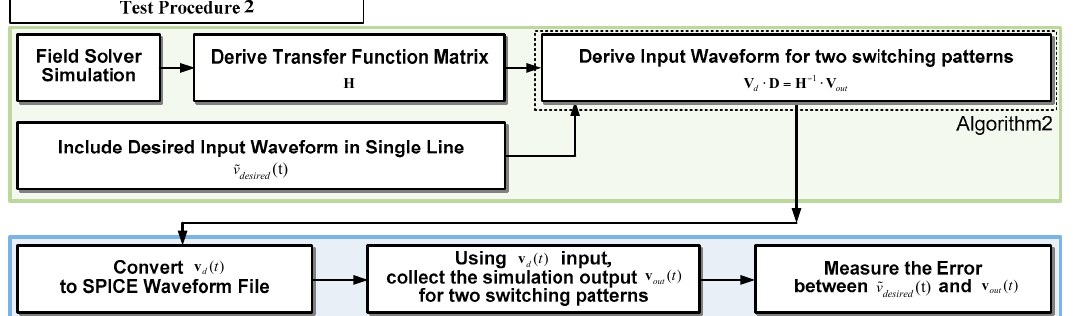
Figure 7. Test procedure for a two-coupled line system.